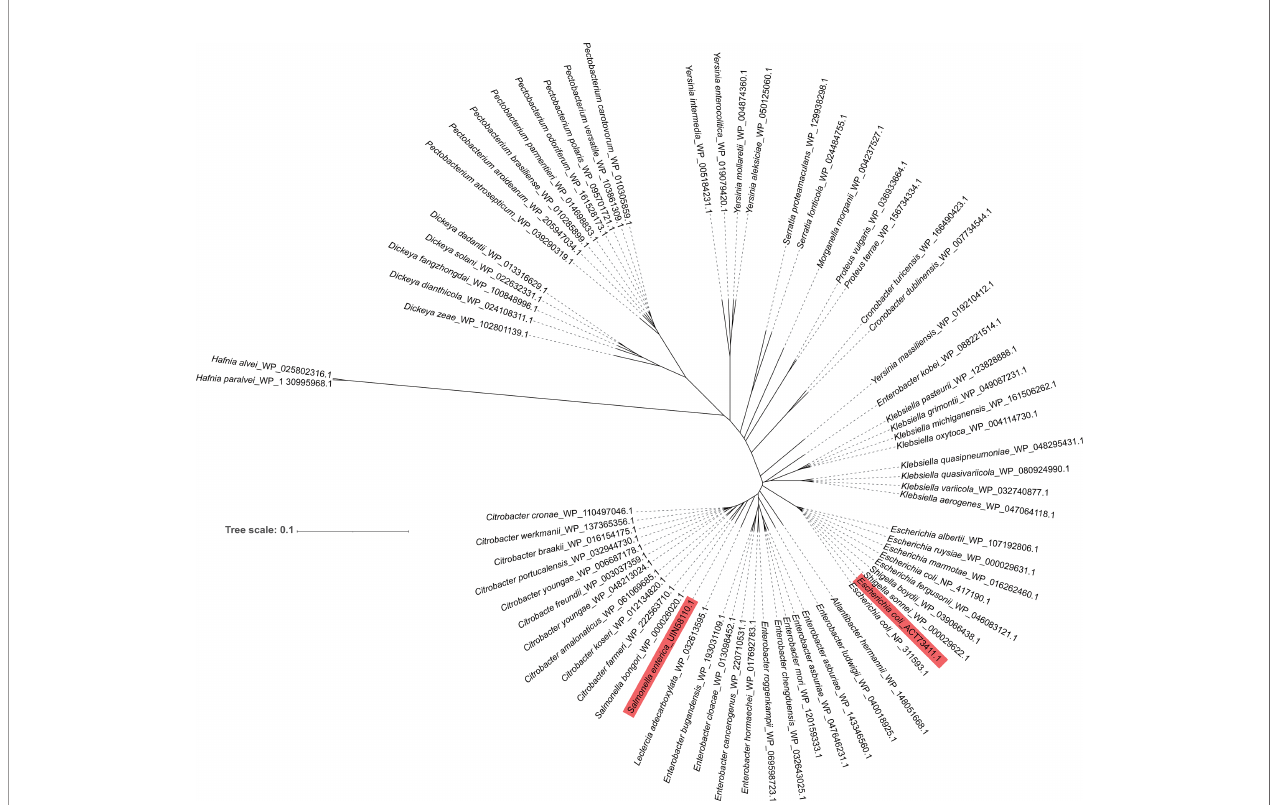
FIGURE 4 | Phylogenetic analysis of FlRd on 69 Enterobacteriaceae strains including S. Typhimurium_zhang and TW14359 Amino acid sequence of FlRd on 69 Enterobacteriaceae strains including S. Typhimurium_zhang and TW14359 were downloaded from NCBI and included in the phylogenetic analysis. FlRd=anaerobic nitric oxide reductase fl avorubredoxin. FlRd of S. Typhimurium_zhang (Salmonella enterica_UIN58110.1) and TW14359 ( Escherichia coli _ACT73411.1) were highlighted in the phylogenetic